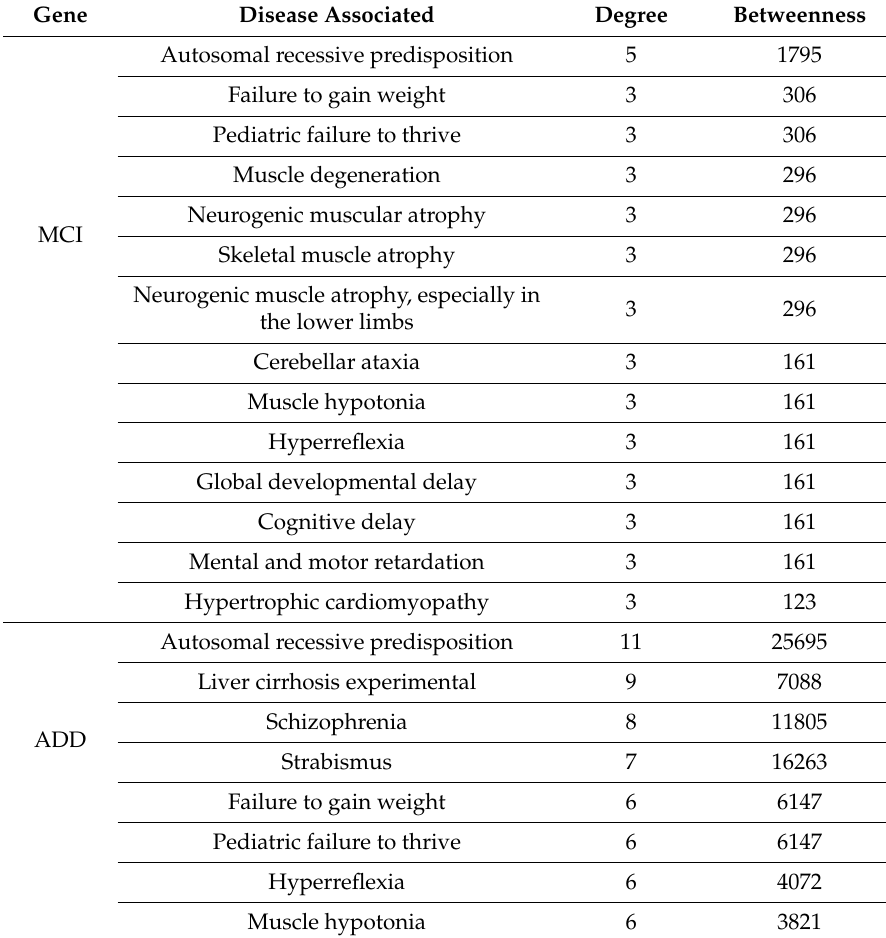
Table 3. Disease association